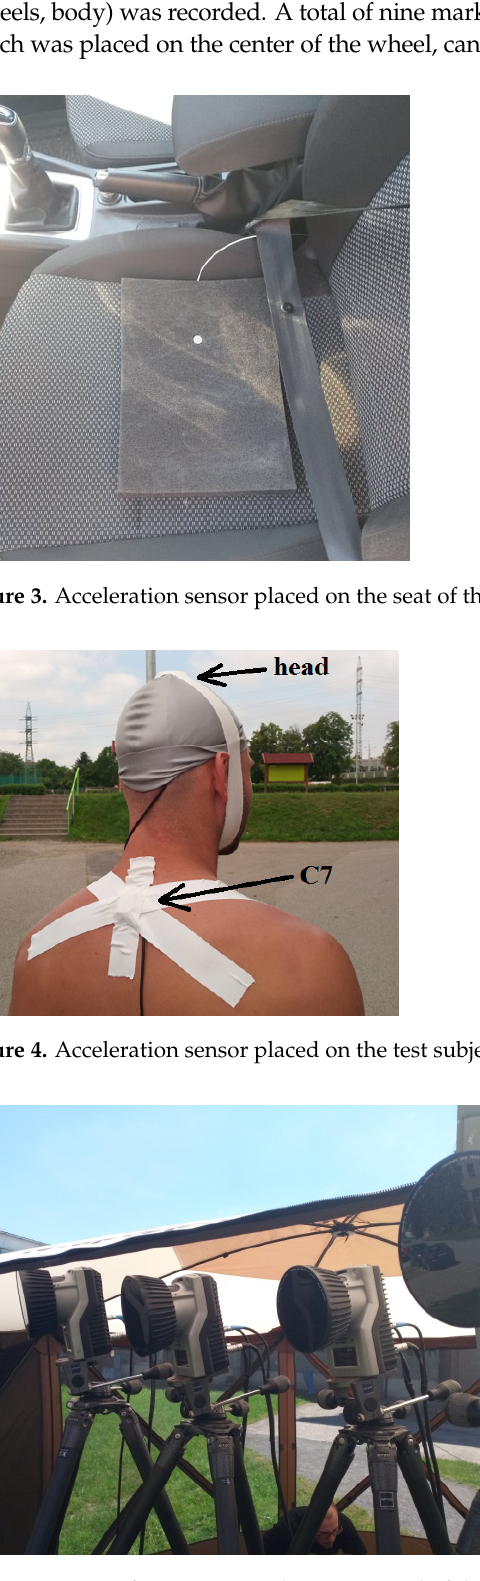
( a ) ( b ) Figure 6. Markers placed on the vehicle: ( a ) wheel of the vehicle and ( b ) body of the vehicle. 3. Measurements Results Table 2 shows the average values of the obstacle acceleration measured on the driver (human) of a passenger car vehicle (average acceleration values for measurement variants V1 to V35). Table 3 shows the average values of the obstacle acceleration measured on the passenger (human) of a passenger car (measurement variants V36 to V70). Table 2. Average values of accelerations for driver-variants V1 to V35. Velocity [km.hod − 1 ] Measured Acceleration Values Seat Construction [m.s − 2 ]